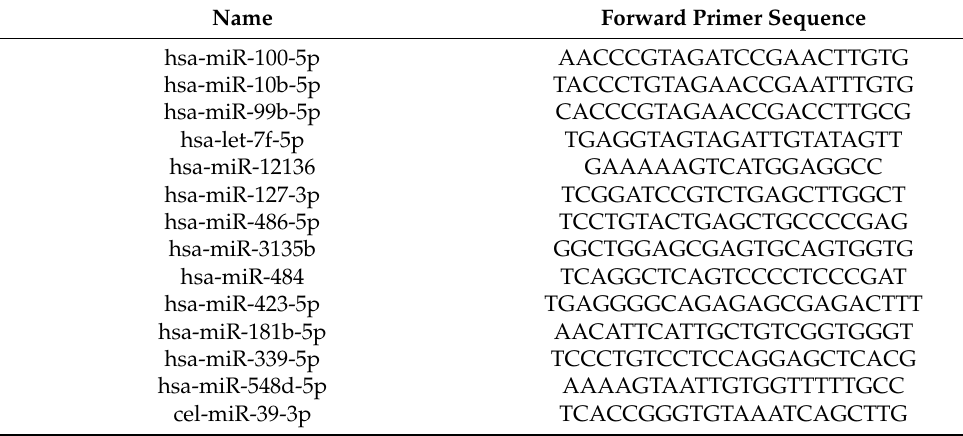
Table 2. Forward primer sequences for miRNA RT-qPCR expression